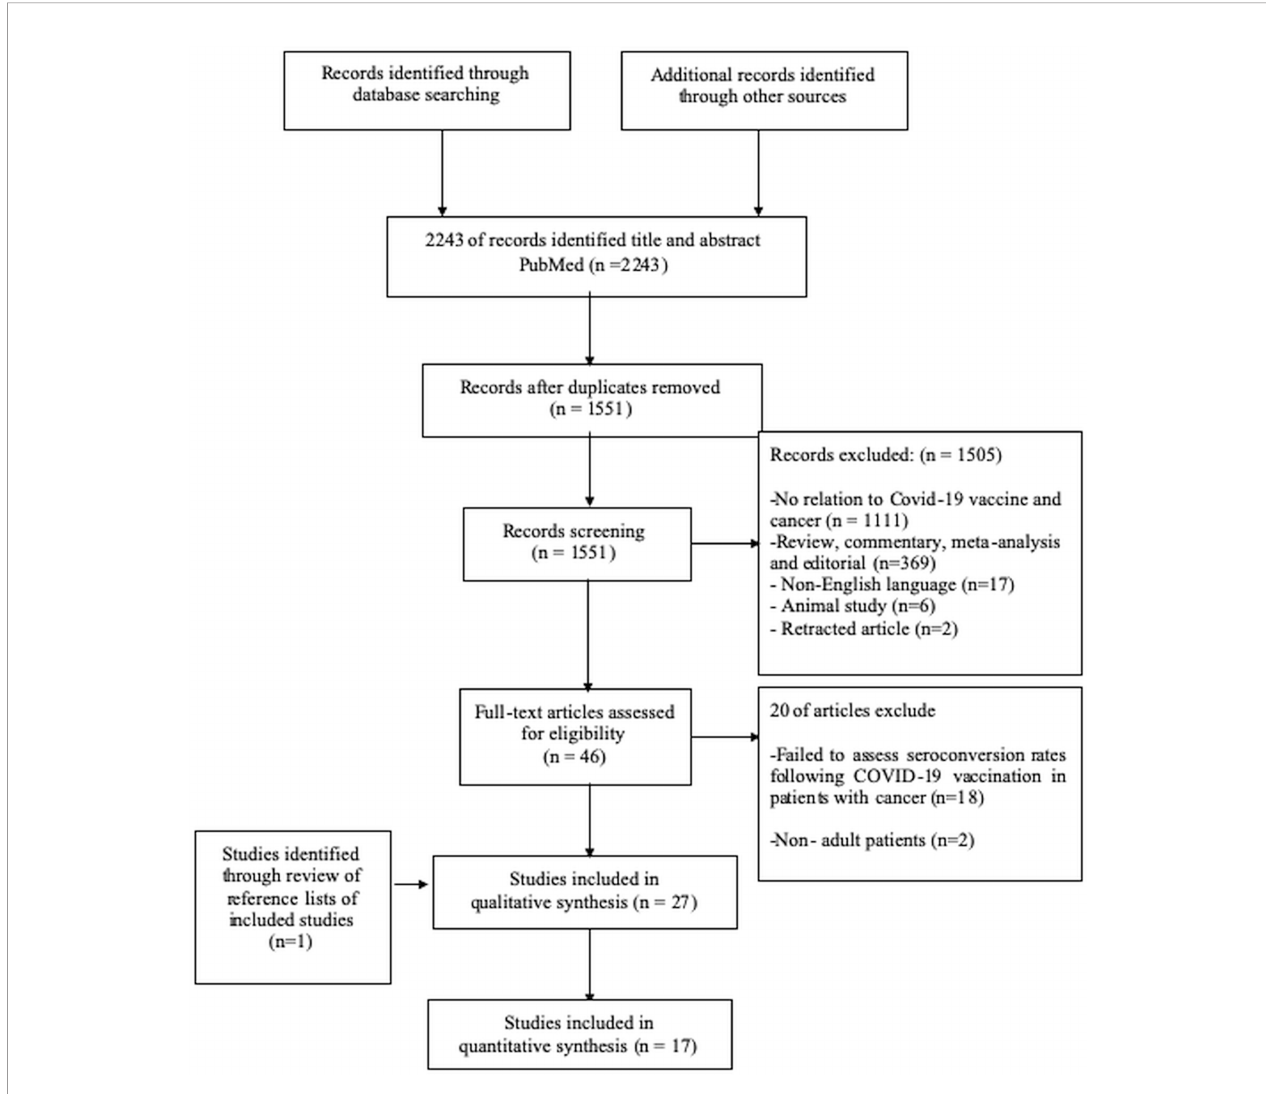
FIGURE 2 | PRISMA fl ow